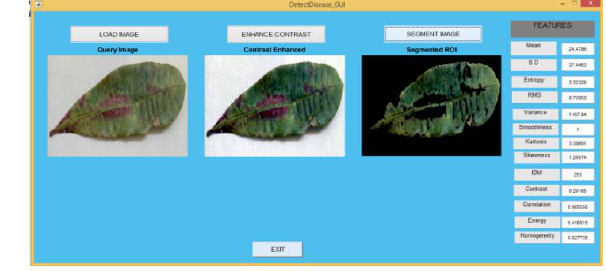
Figure 14. Segmented image from cluster 2 and extracted features using